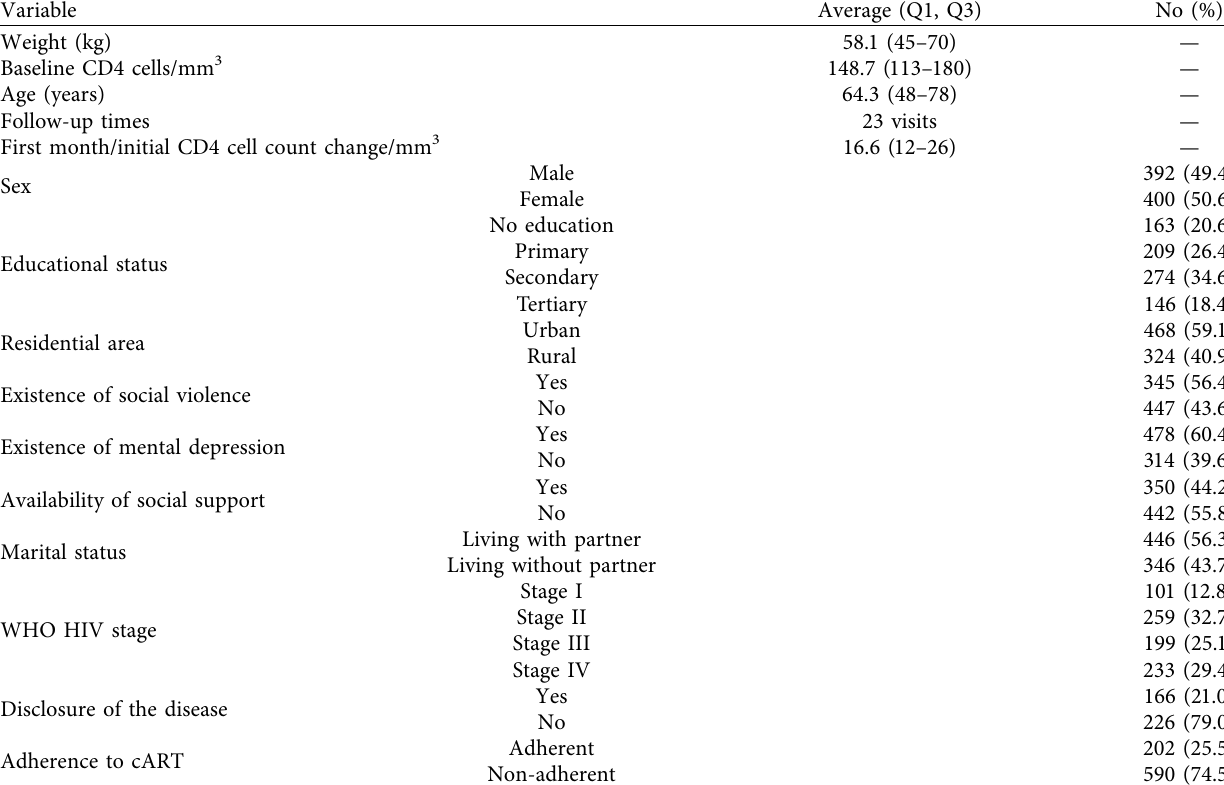
Table 1: Baseline sociodemographic and clinical variables of 792 participants in the study area